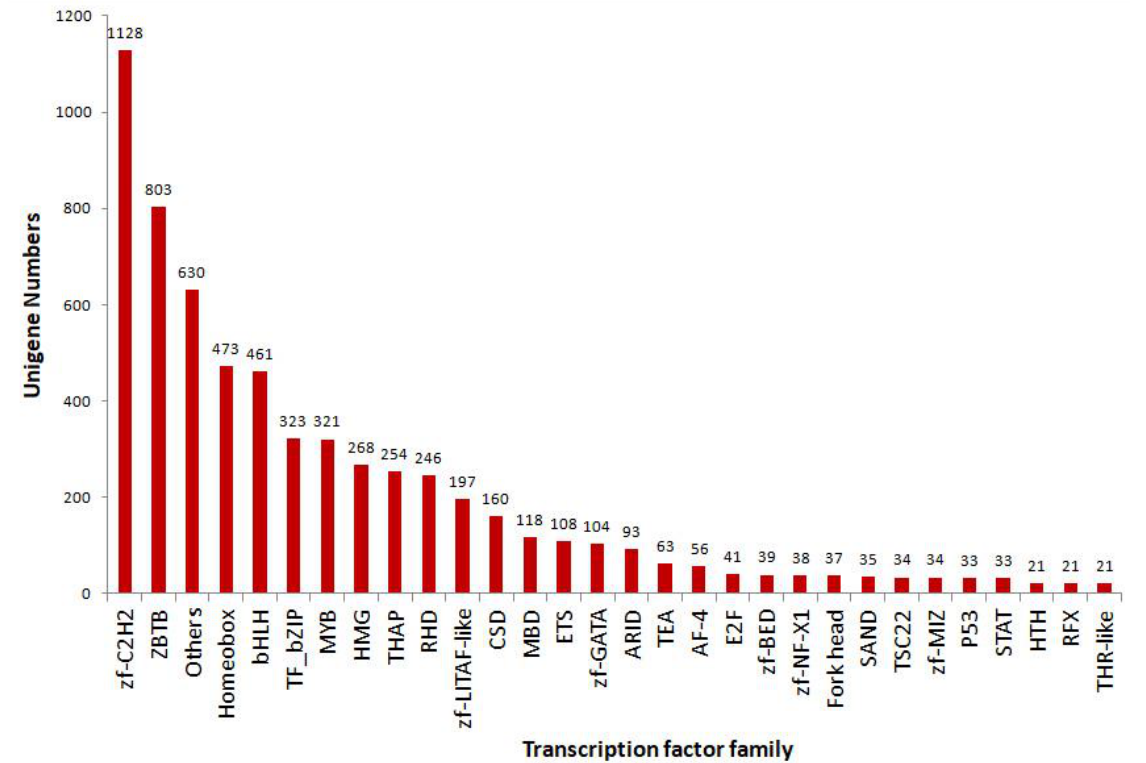
Figure 2. Annotated pathways and numbers of unique transcripts of M. rosenbergii by KEGG data- base.